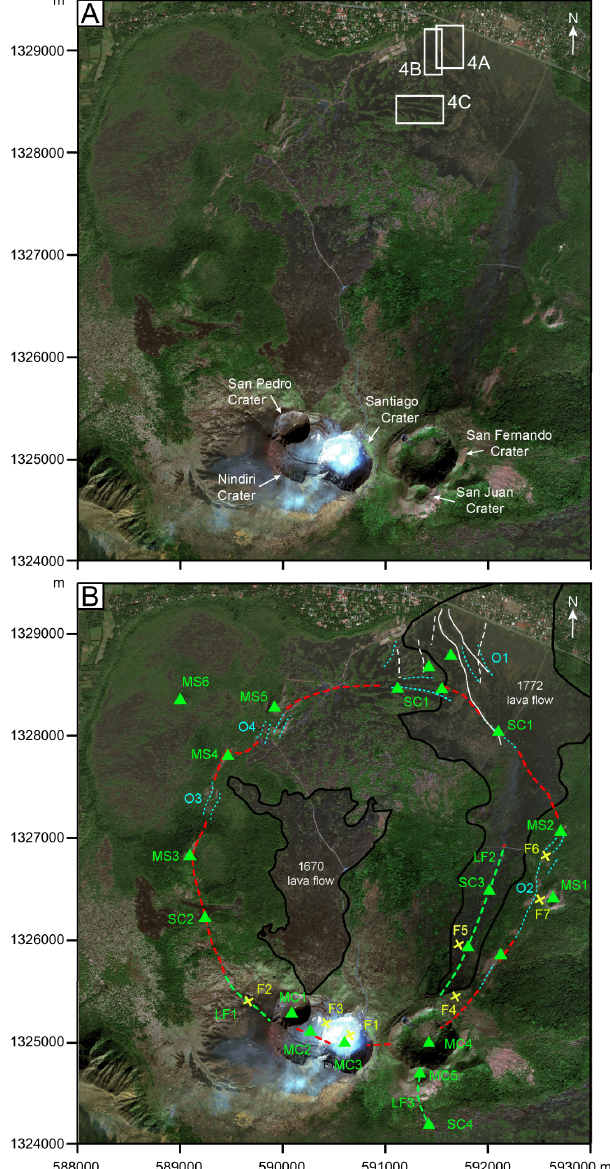
Figure 2: Location of relevant structural features within Masaya Caldera. [A] Image of the northern part of Masaya caldera. White boxes and 4A, B, C denote ar- eas presented in Figure 4. [B] Annotated image. Red dashed line approximates the surface trace of a cir- cular structure based on the alignment of structural evidence. Green triangles represent eruptive centres, including the main pit craters (MC), medium sized cones (MS) and spatter cones/ramparts (SC). Yellow X symbols represent fumaroles and degassing spots (F). Green dashed lines represent large fissures (LF) source of past eruptions. Cyan lines represent openings, frac- tures and cracks (O). White continuous lines represent inflation fractures, white dashed lines indicate frac- tures parallel to the Cofradías fault. See Appendix 1 for details. The 1670 and 1772 lava flows are outlined in black. Base image from ESRI World Imagery, UTM zone